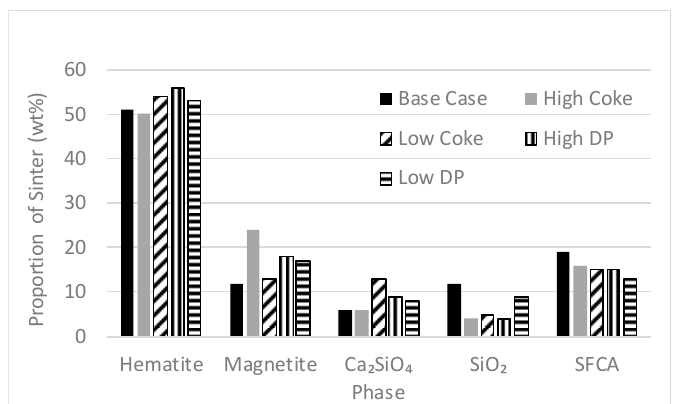
Figure 6. Proportions of phases in the sinter product as determined by semi-quantitative X-Ray Diffraction (XRD).